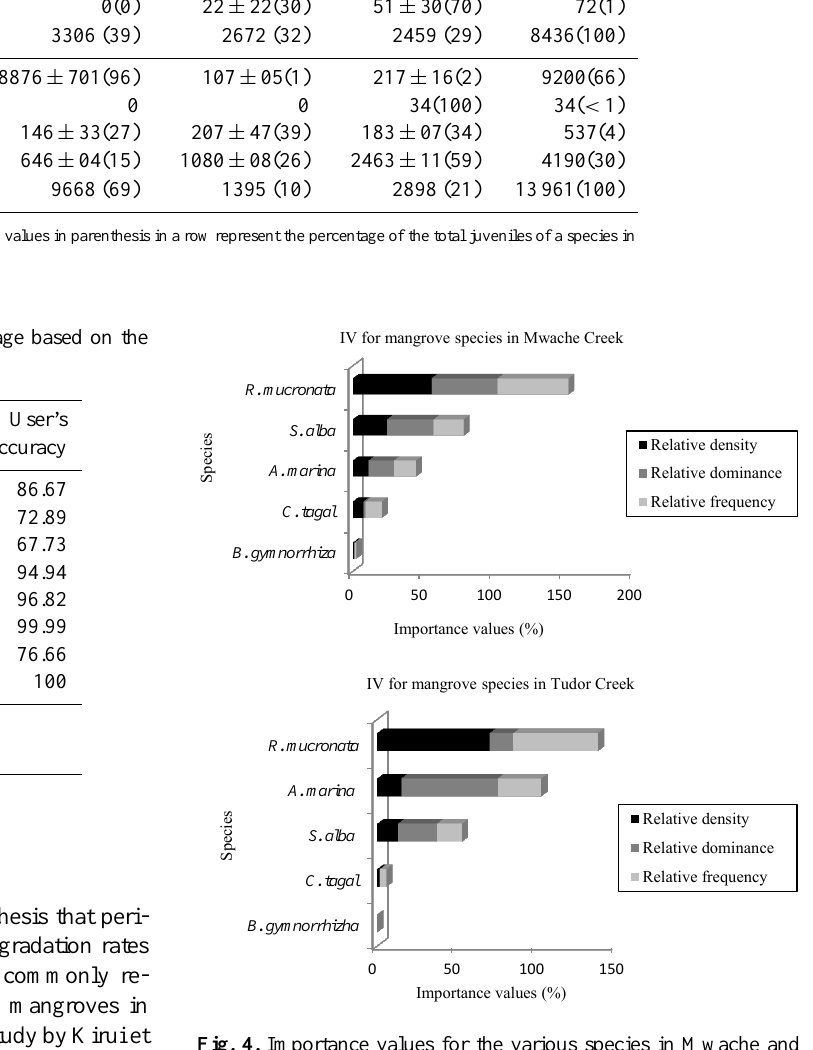
Figure 4: Importance Values for the various species in Mwache and Tudor creeks 18 Fig. 4. Importance values for the various species in Mwache and Tudor